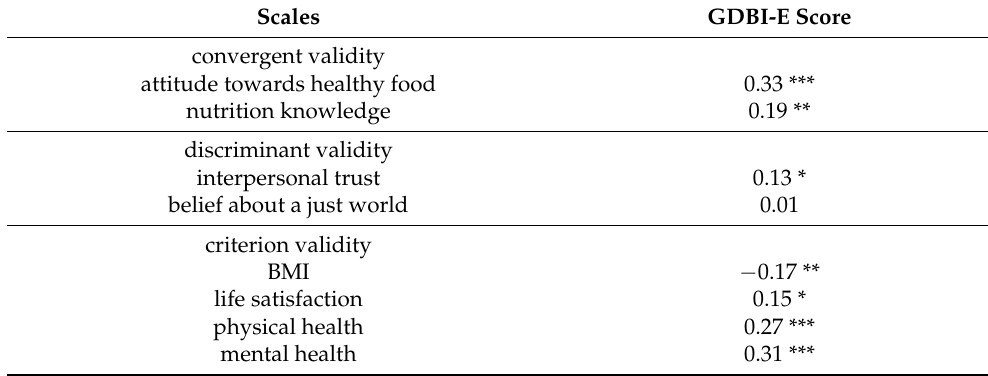
Table 3. Pearson correlation coefficients for construct and criterion validity of the GDBI-E score.